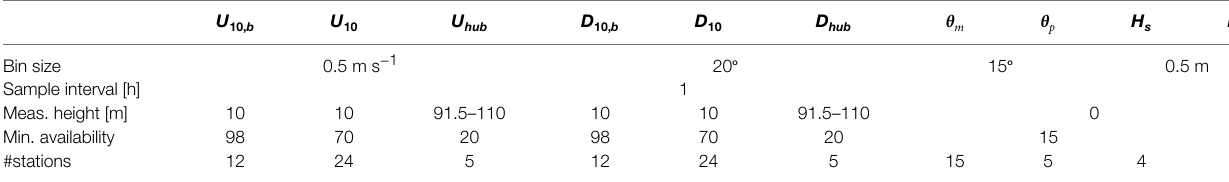
TABLE 2 | Bin size, sample interval, measurement height, minimum (min.) availability and number of stations (#stations) for 10-m and hub height ( hub ) wind speed ( U ) and wind direction ( D ) and for the significant wave height ( H s ) in one and 3 hour resolution and for wave direction in terms of both peak ( θ p ) and mean direction ( θ m ). Subscript ‘b’ refers to the base sample (Section 2.1.1).